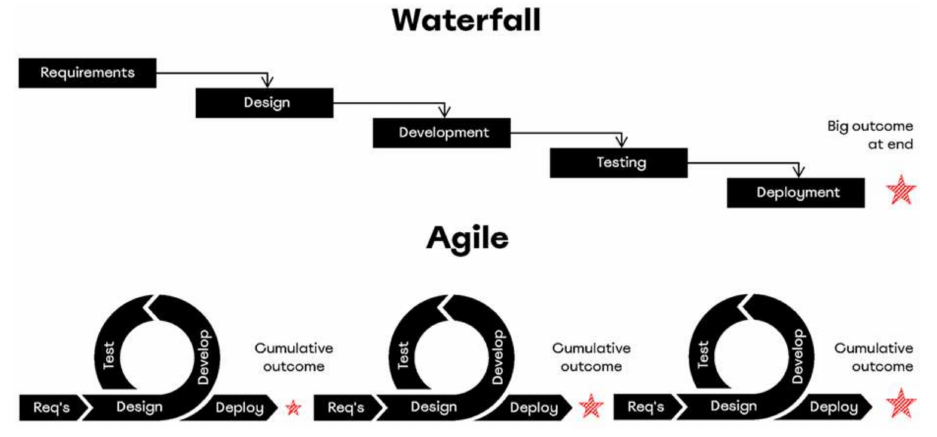
Figure 1. Waterfall and Agile